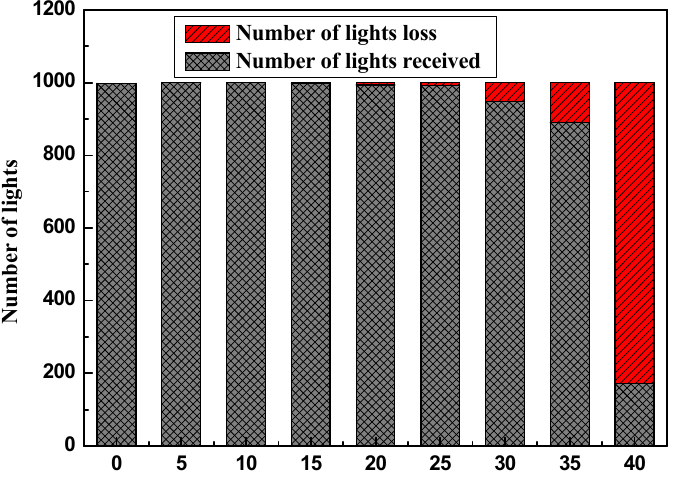
Figure 5. Ray tracing outcome for the solid dielectric CPC without mirror